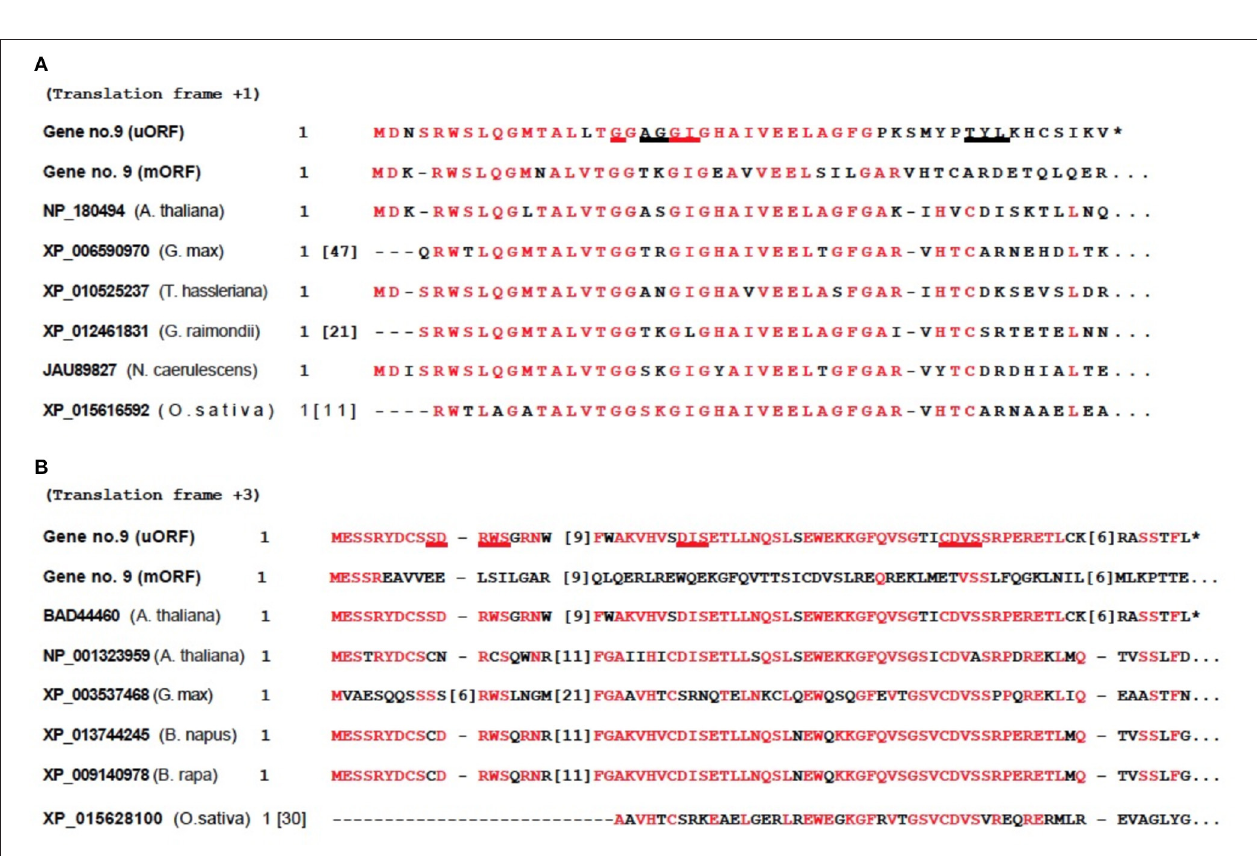
FIGURE 4 | Conserved domains detected in 5 ′ -UTR of AT2G29290 (gene 9). Annotations on the left are NCBI accession numbers and species. Numbers in brackets represent omitted amino acids. Identities between protein sequences are highlighted in red, and potential ligand binding sites are underlined. These proteins are members of the short-chain dehydrogenases/reductases (SDR) family, which belongs to the Rossmann-fold NAD(P)( + )-binding proteins superfamily. (A) Nicotinamide-adenine-dinucleotide (NAD), ligand binding sites at G17 A19 G20 G21 I22 T41 Y42 L43. The mORF within the bicistronic 1,833-nt mRNA transcript, GenBank no. NM__001124936 from gene no. 9, was used here. (B) Nicotinamide-adenine-dinucleotide phosphate (NADP), ligand binding sites at S10 D11 R12 W13 S14 D36 I37 S38 C61 D62 V63 S64. The mORF within the bicistronic 1,361-nt mRNA transcript, GenBank no. NM_128483 from gene no. 9, was used here. The sequence with accession number BAD44460 from A. thaliana is from a polyadenylated uORF short transcript accidentally discovered by others, and is a conceptual translation of the